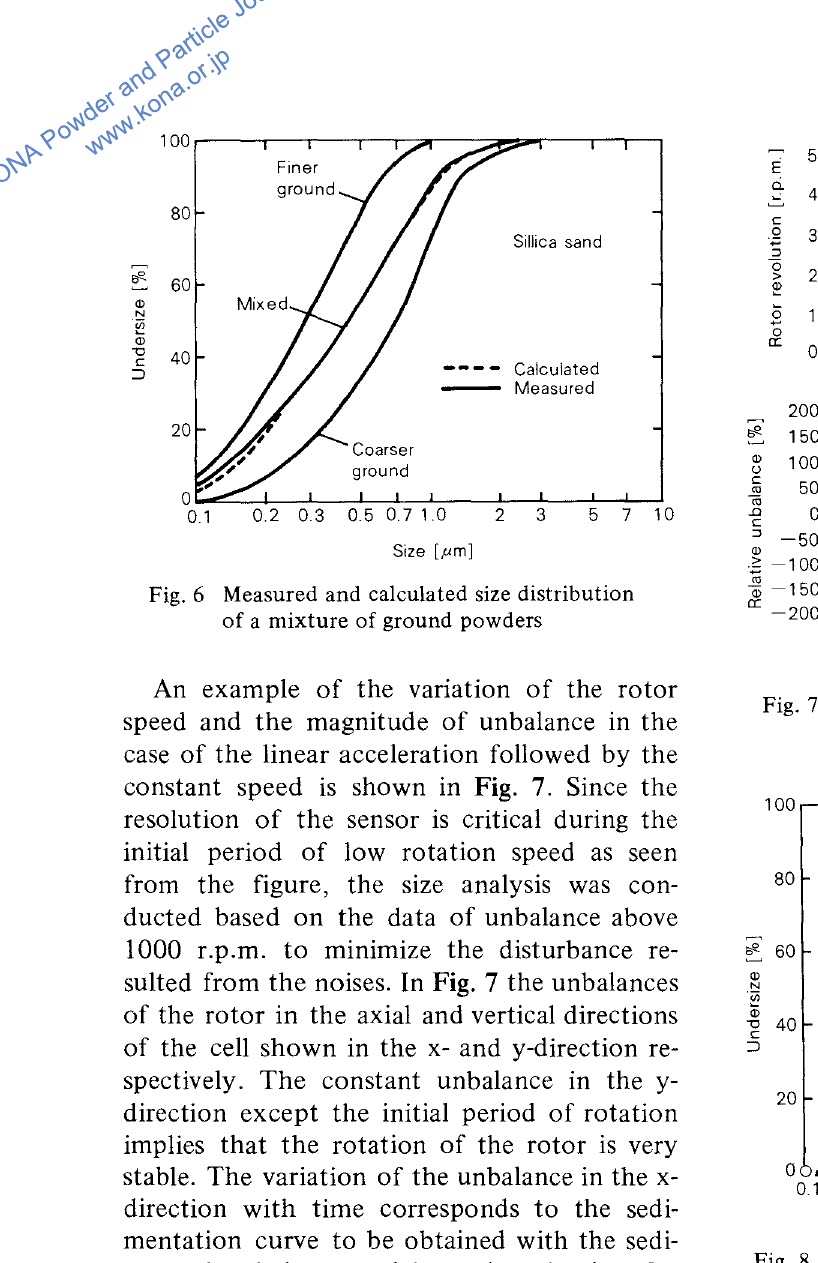
Fig. 8 Comparison of the measurement at a constant rotation with that .of the linear acceleration